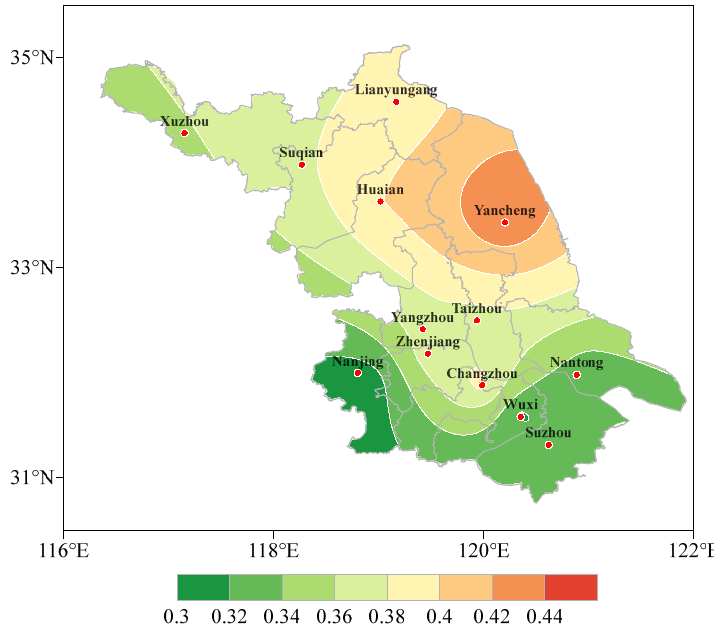
Figure 10. Storm patterns of the 9 maximum rainfall events lasting about 120 min in Nanjing ( a – i ).